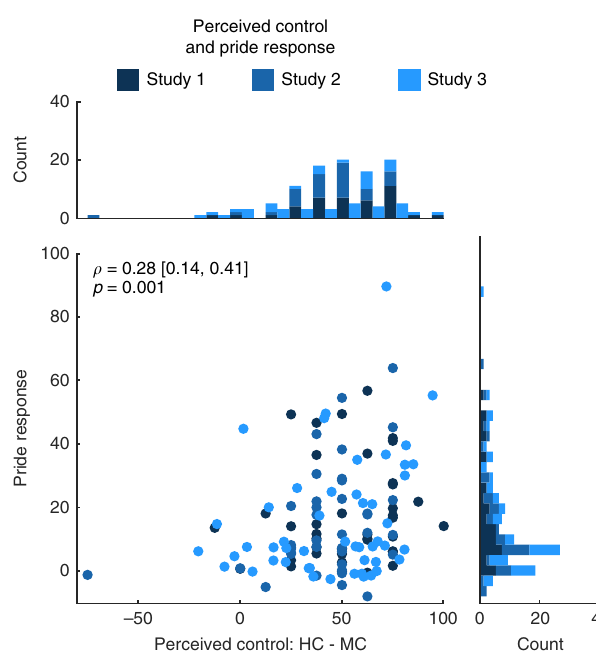
Fig. 8 Pride and perceived control. The scatterplot depicts the relationship between internal control beliefs and pride response across all three studies. Dark blue indicates data point belongs to study 1, intermediate blue to study 2, and light blue to study 3. Raw controllability ratings were transformed to a range between 0 and 100, across internal control conditions, before computing the difference between HC and MC in each study. For study 1, raw control and pride ratings were averaged across LC and MC. The pride response is the interaction term for pride ([HC:WIN – HC:noWIN] – [MC: WIN – MC:noWIN]). Histograms display the difference in perceived control (top), and the pride response (right). ρ = Spearman ’ s rho. Values in brackets represent lower and upper bounds of the 90% con fi dence interval for ρ . Source data are provided as a Source Data fi